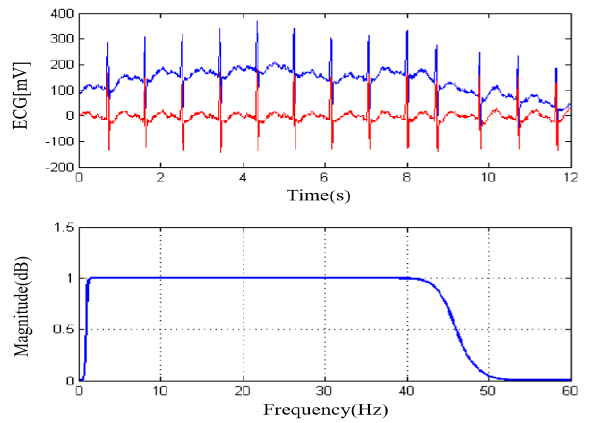
Figure 2. IIR bandpass filter applied to a ’Normal’ type ECG. The input temporal signal is plotted in blue and the filtered output signal is plotted in red. Its frequency response is shown